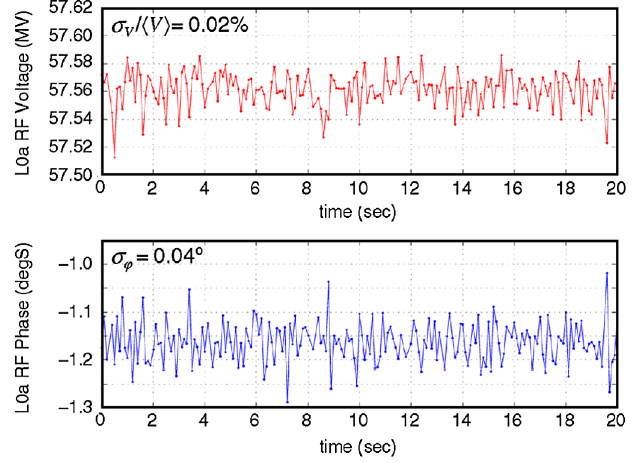
FIG. 18. (Color) The rf amplitude (top) and rf phase jitter (bottom) of the L0a rf section measured over 20 seconds at a 10-Hz sample rate (feedback active).